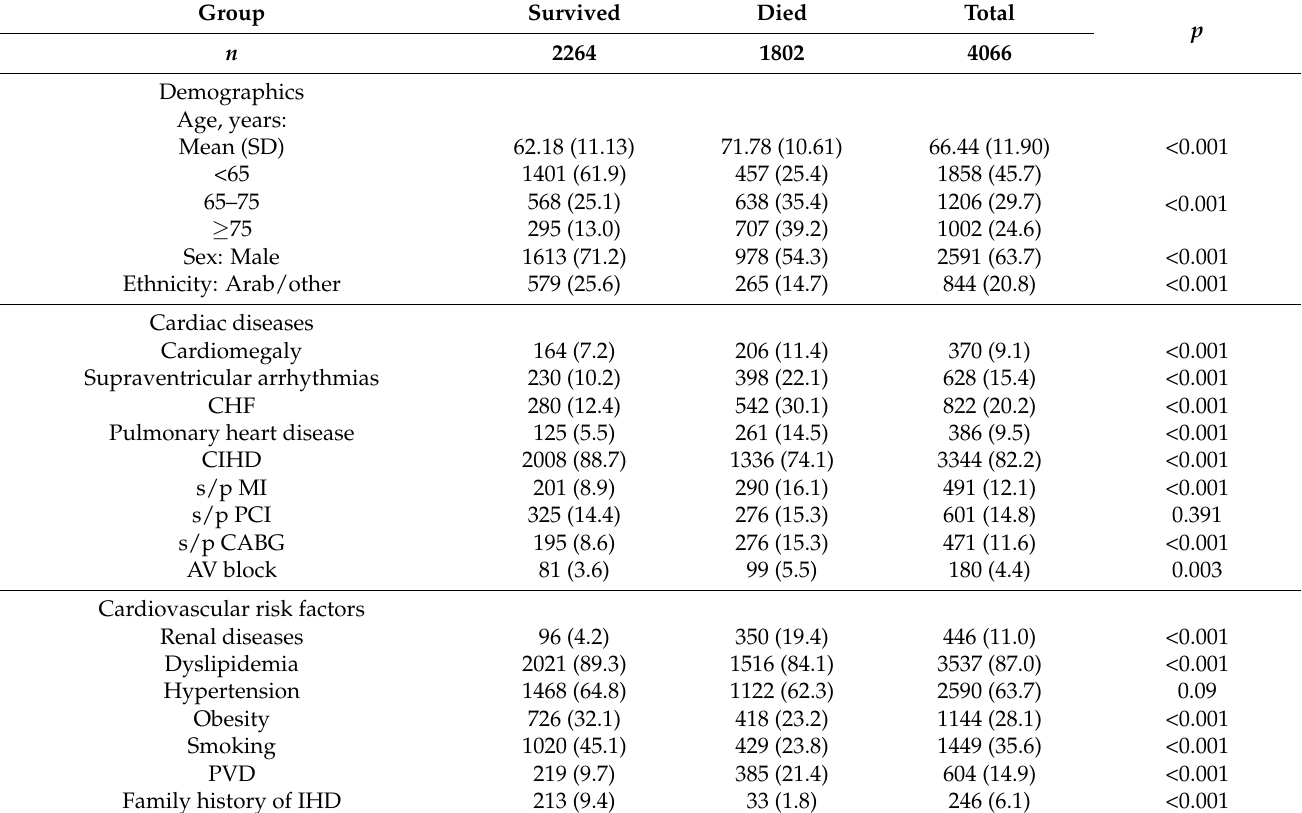
Table 1. Baseline characteristics and comparisons between patients who died and those who